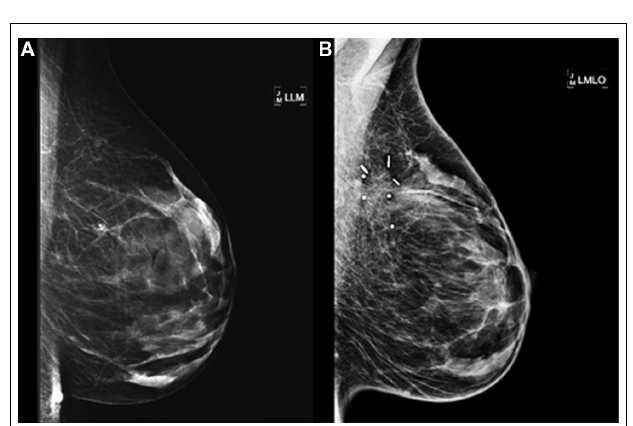
FIGURE 3 | Pre- and post-CyberKnifeAPBI mammograms. (A) A left breast mammogram showing a biopsy clip in the tumor on a left lateral medial (LLM) view. (B) A left medial lateral oblique view of the same patient taken 14months after CyberKnife APBI showing four gold fiducials